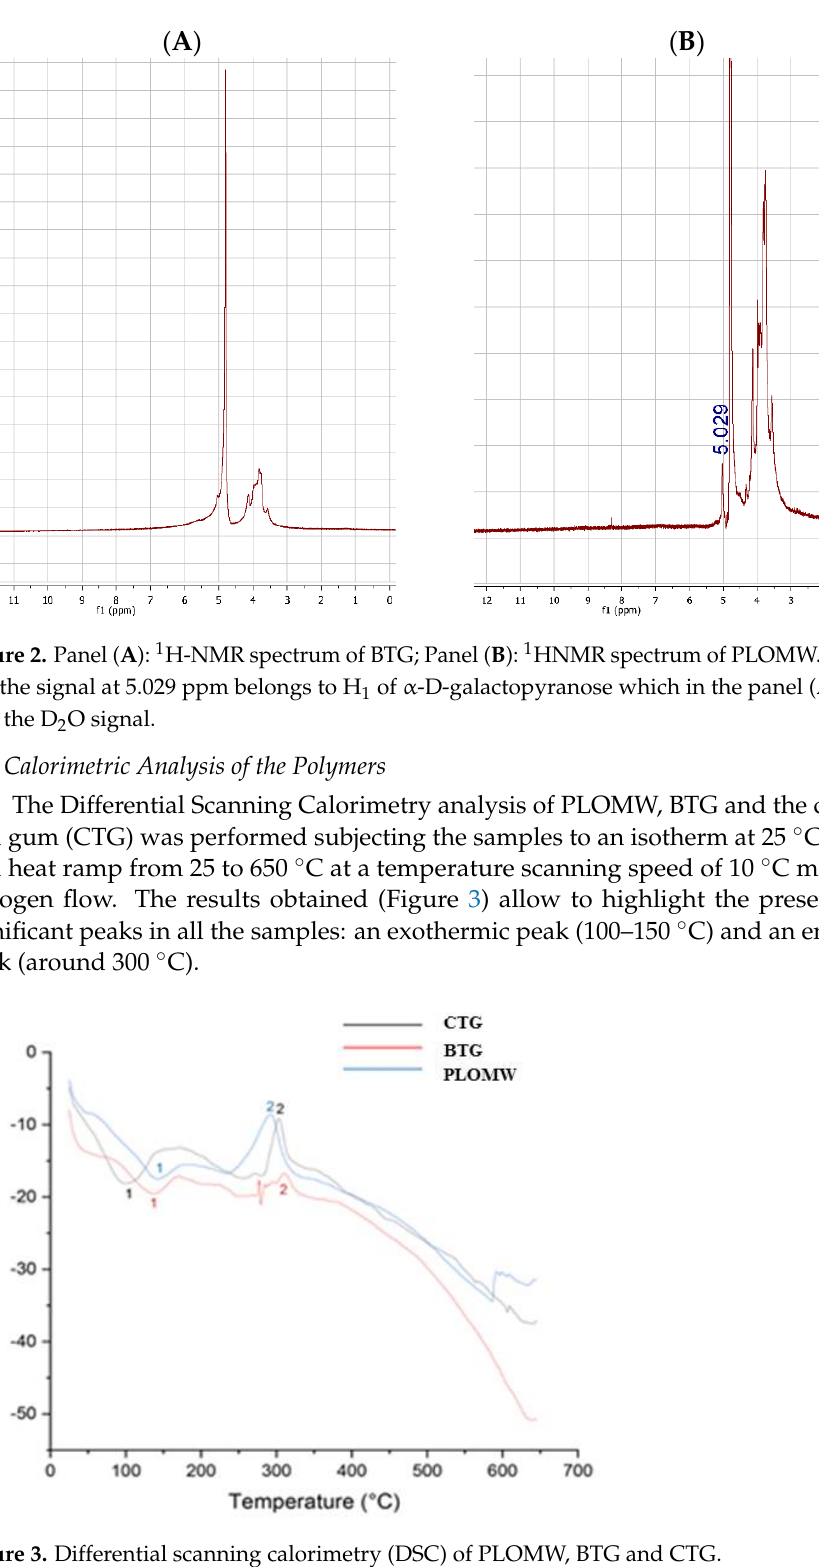
Figure 3. Differential scanning calorimetry (DSC) of PLOMW, BTG and CTG. Table 4. Enthalpy and temperature values of the polymers and commercial tare rubber